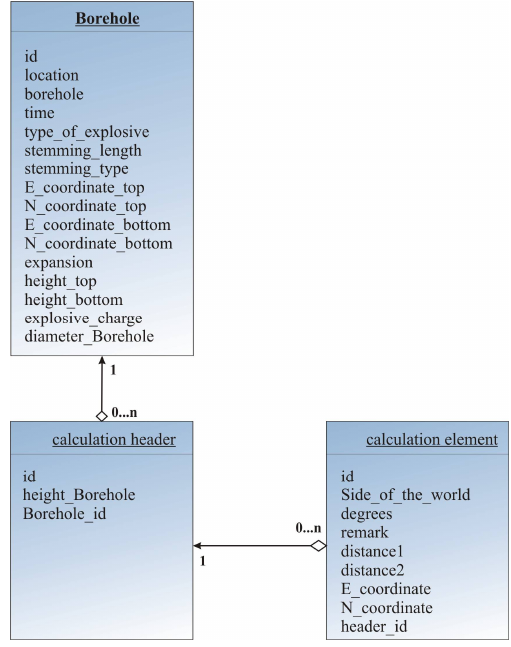
Figure 3. Database model